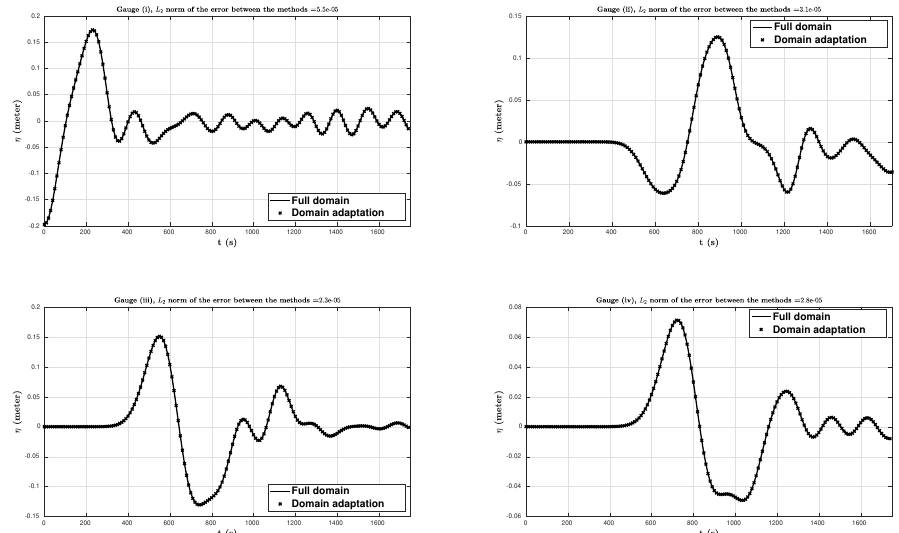
Figure 16. Passive generation: comparison between the two methods the full one and domain adaptivity of the free surface elevations (in meters) vs. time (in seconds), computed numerically at four wave gauges where the gauge (i) corresponds to the epicenter.